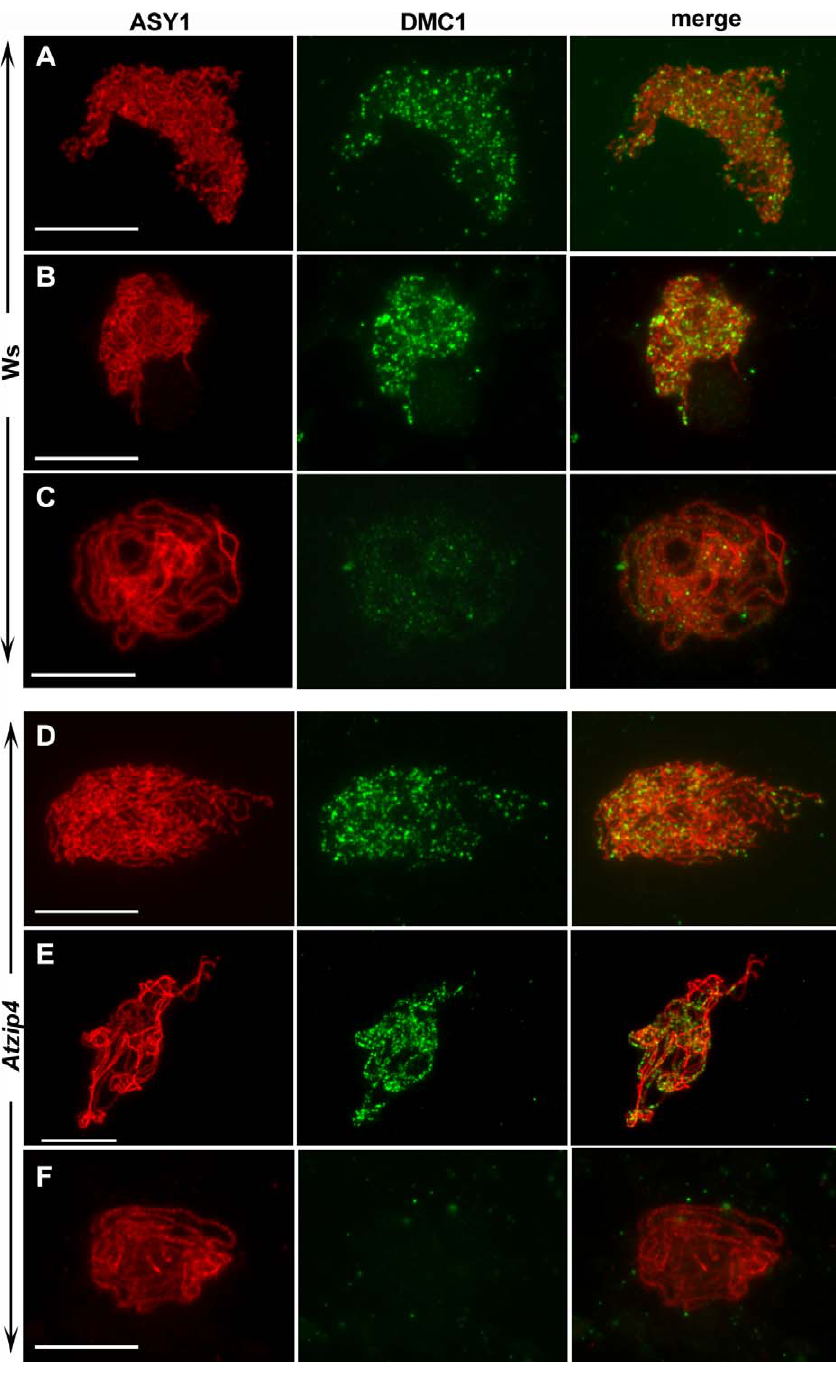
Figure 5. Coimmunolocalization of ASY1 and AtDMC1 in Wild-Type and Mutant Meiocytes Coimmunolocalization of ASY1 (red) and DMC1 (green) in wild-type (Ws) and Atzip4–1 (Atzip4) PMCs. For each cell, each single staining is shown as well as the overlay of both signals (merge). (A and D) Leptotene, (B and E) zygotene, (C and F) pachytene. Bar, 10 l m.